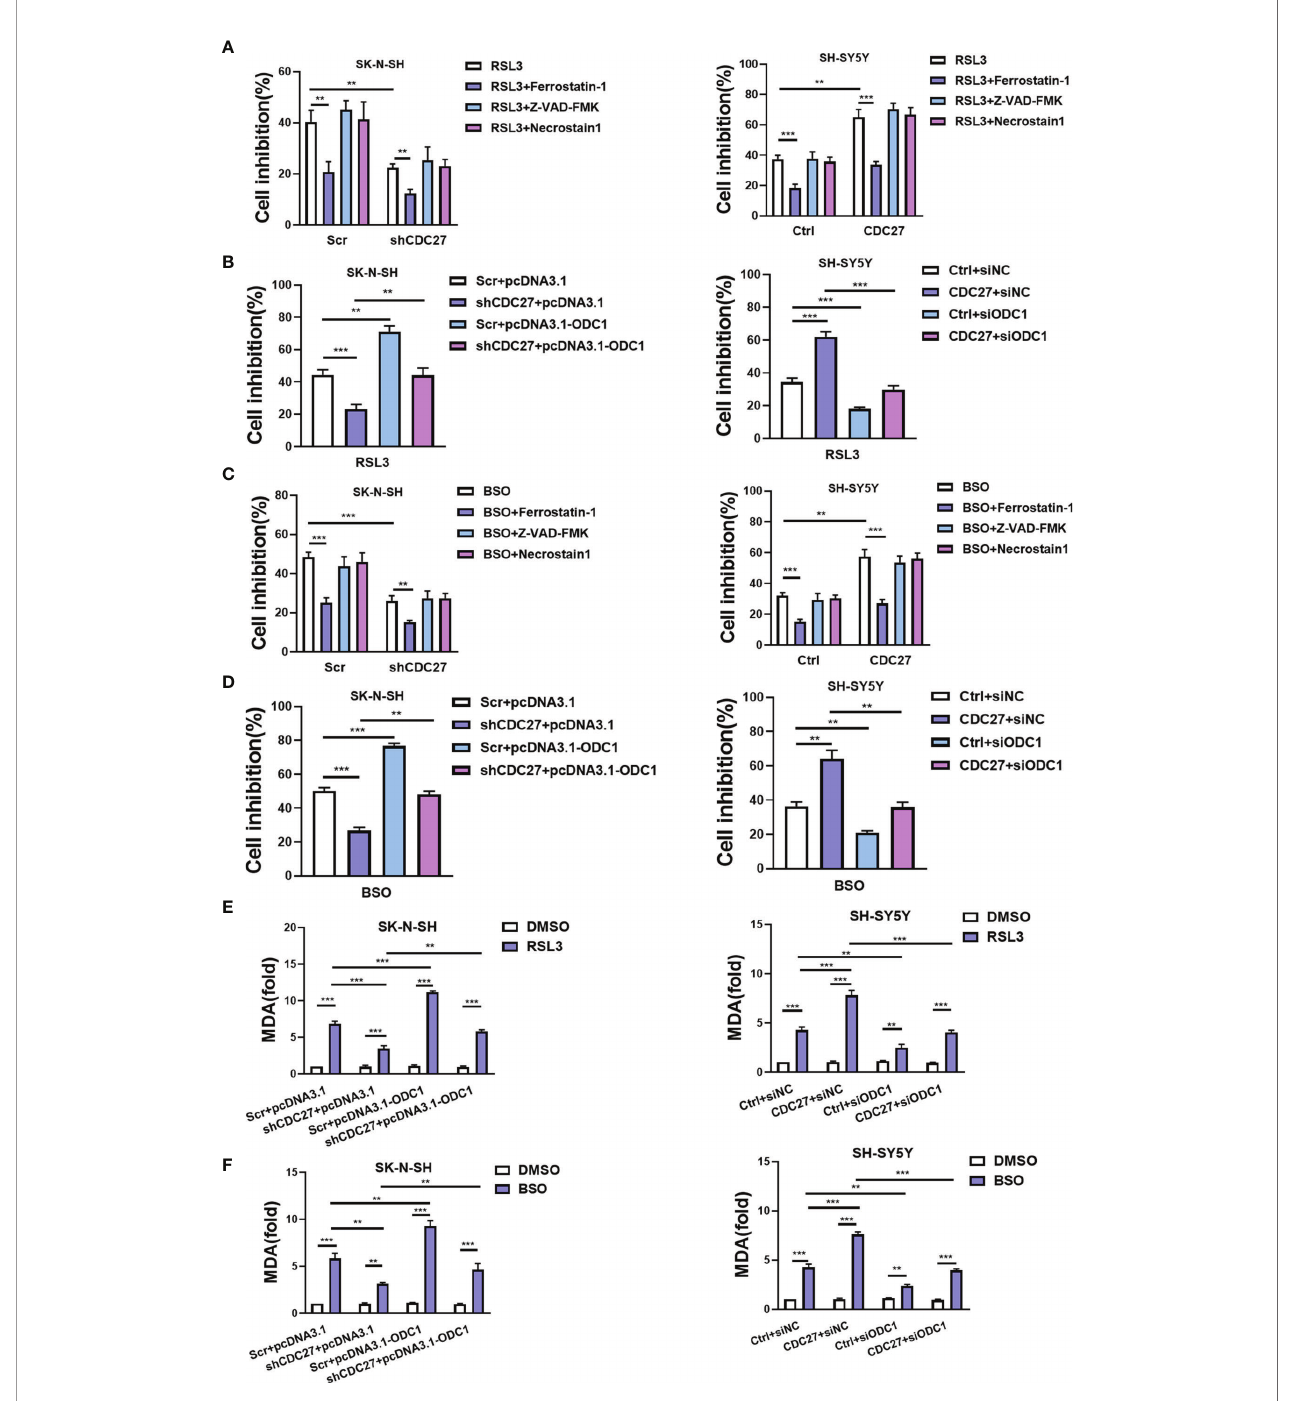
FIGURE 5 | CDC27 contributes to ferroptosis of NB cells via regulation of ODC1. (A, C) The indicated cells were treated with RSL3 (ferroptosis inducer, 1 m M) or BSO (ferroptosis inducer, 5 m M), ferrostatin-1 (ferroptosis inhibitor, 1 m M), Z-VAD-FMK (caspase inhibitor, 10 m M) or necrostatin-1 (necroptosis inhibitor, 10 m M) for 24 h, and the WST assay results are shown. (B, D) The indicated cells with transient overexpression or suppression of ODC1 were treated with RSL3 or BSO for 24 h. WST assays were performed. (E, F) MDA content was detected in the indicated cell lines. Means ± SD of triplicate samples are shown. **p < 0.01, ***p < 0.01 based on Student ’ s t